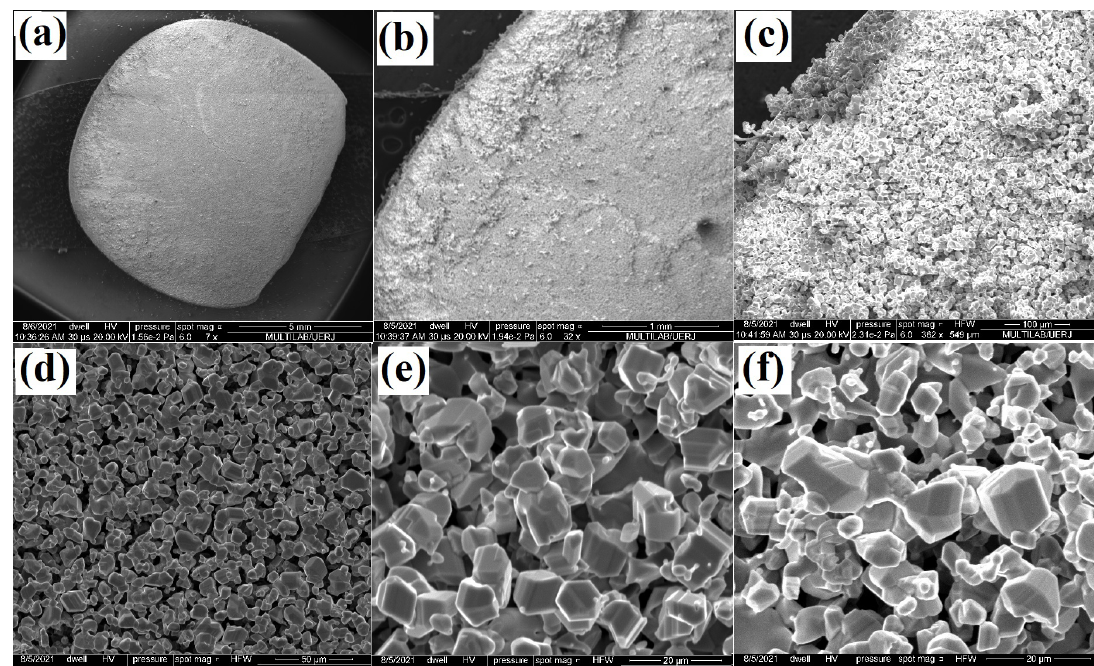
Figure 6. Scanning electronic microscopy (SEM) images of Zn (d) x846, (e) x2539, and (f)